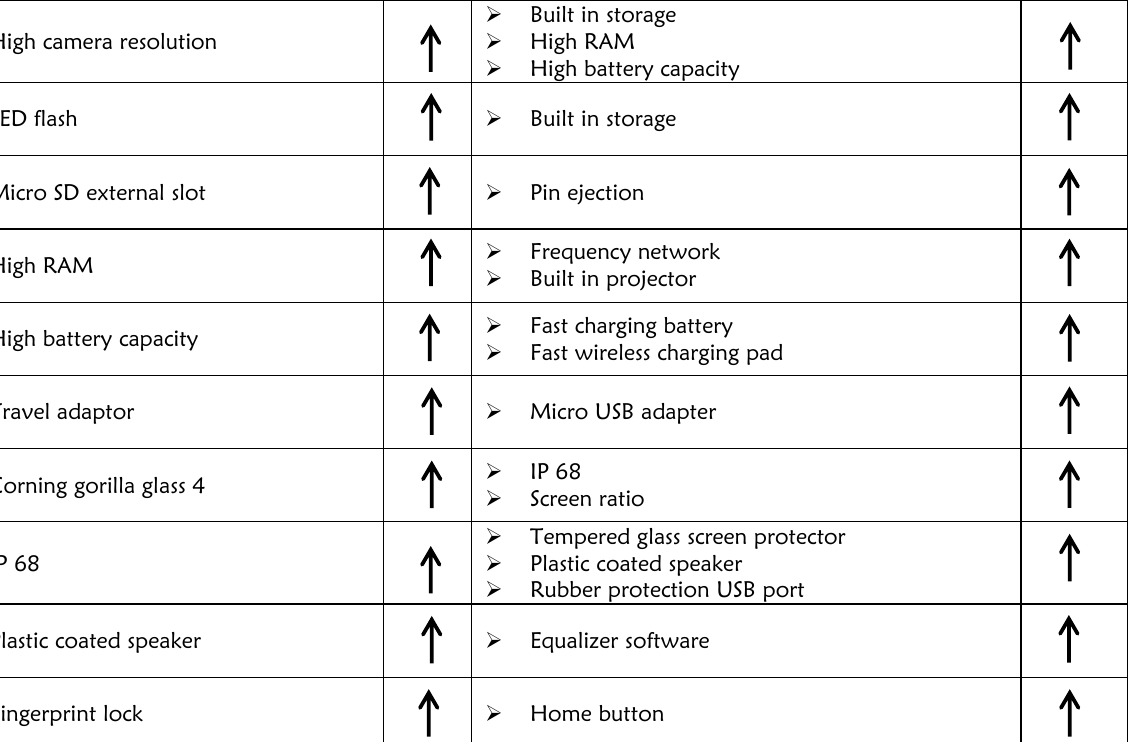
Table 4: Correlation among technical